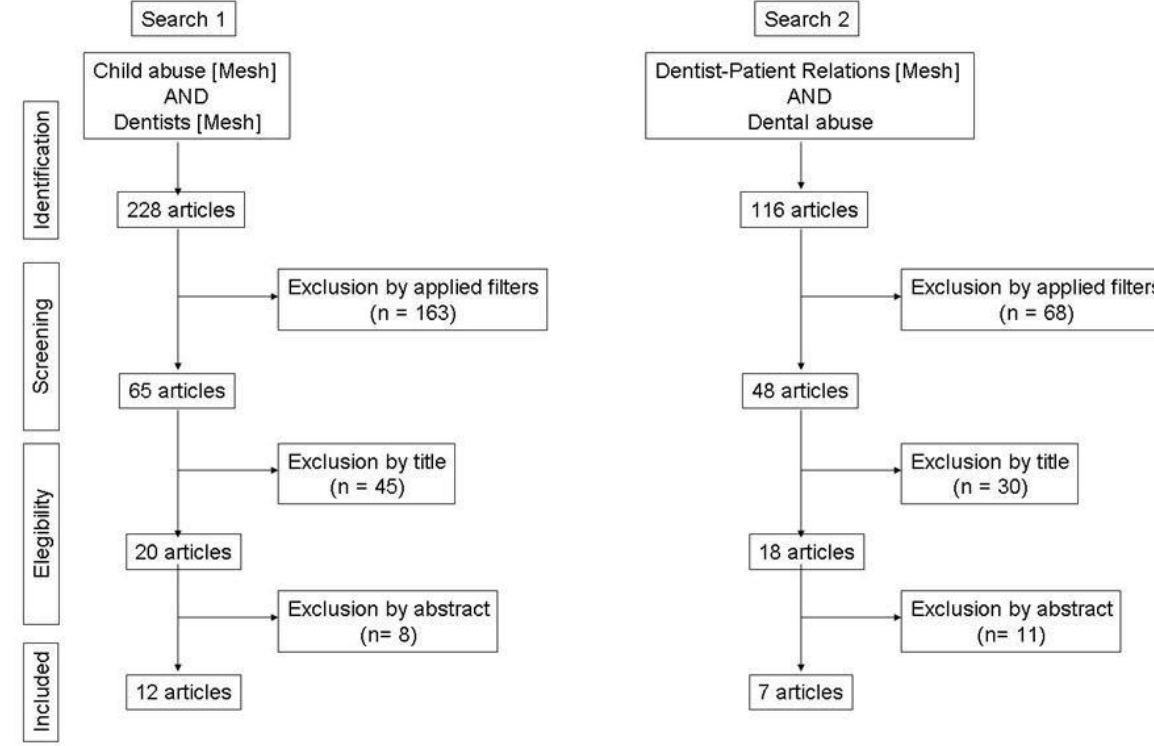
Figure 1: Flowchart of the process of study